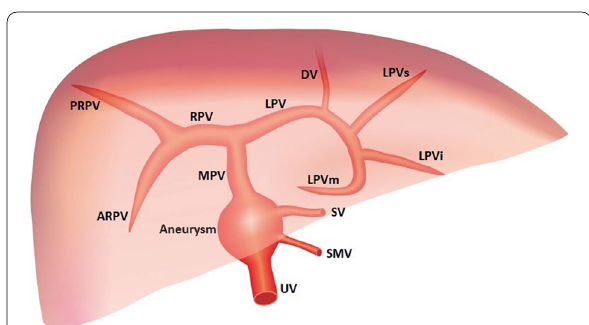
Fig. 19 Scheme of the abnormal connection between the UV and the MPV. The confluence of the UV and the PV presents as